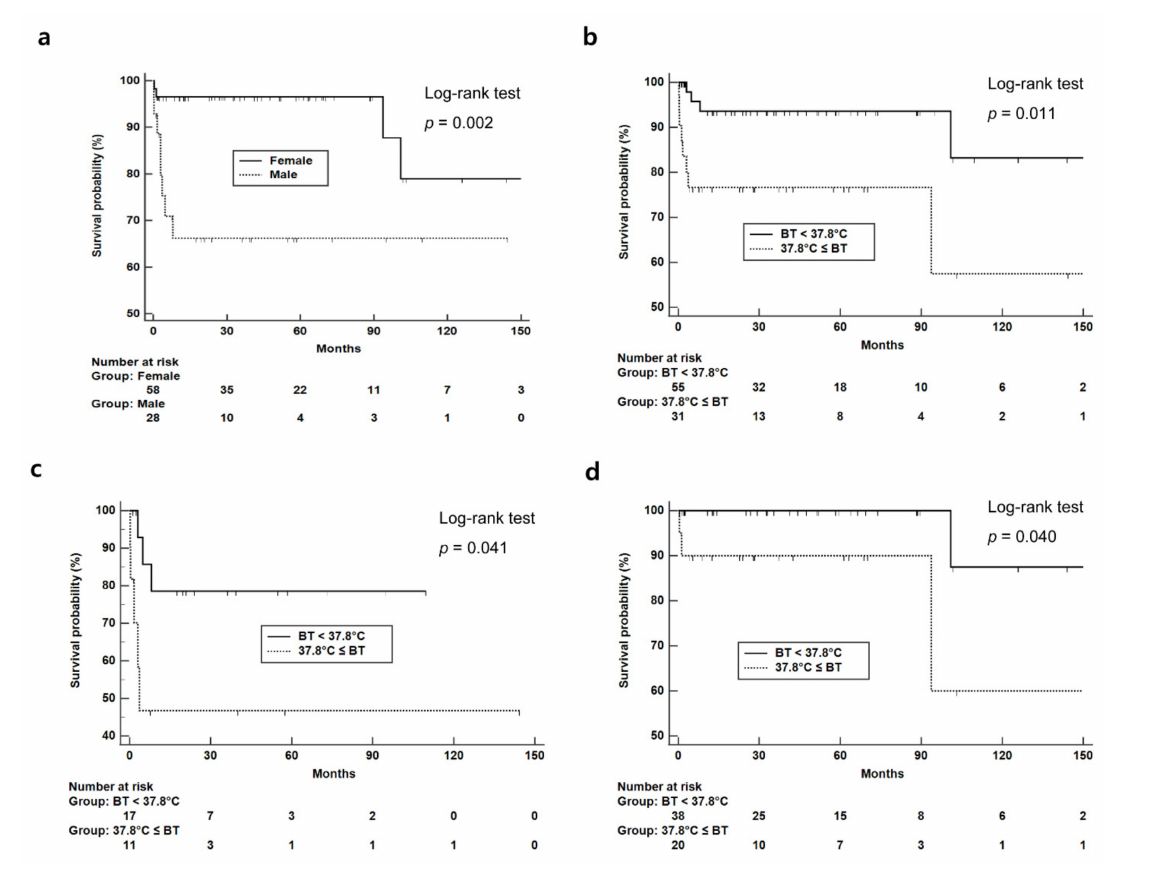
Figure 2. Kaplan–Meier analysis of patient survival based on sex and the presence/absence of fever. The overall survival rate was compared in ( a ) male vs. female patients and in ( b ) total patients, ( c ) male patients, and ( d ) female patients based on the presence and absence of fever. BT: Body